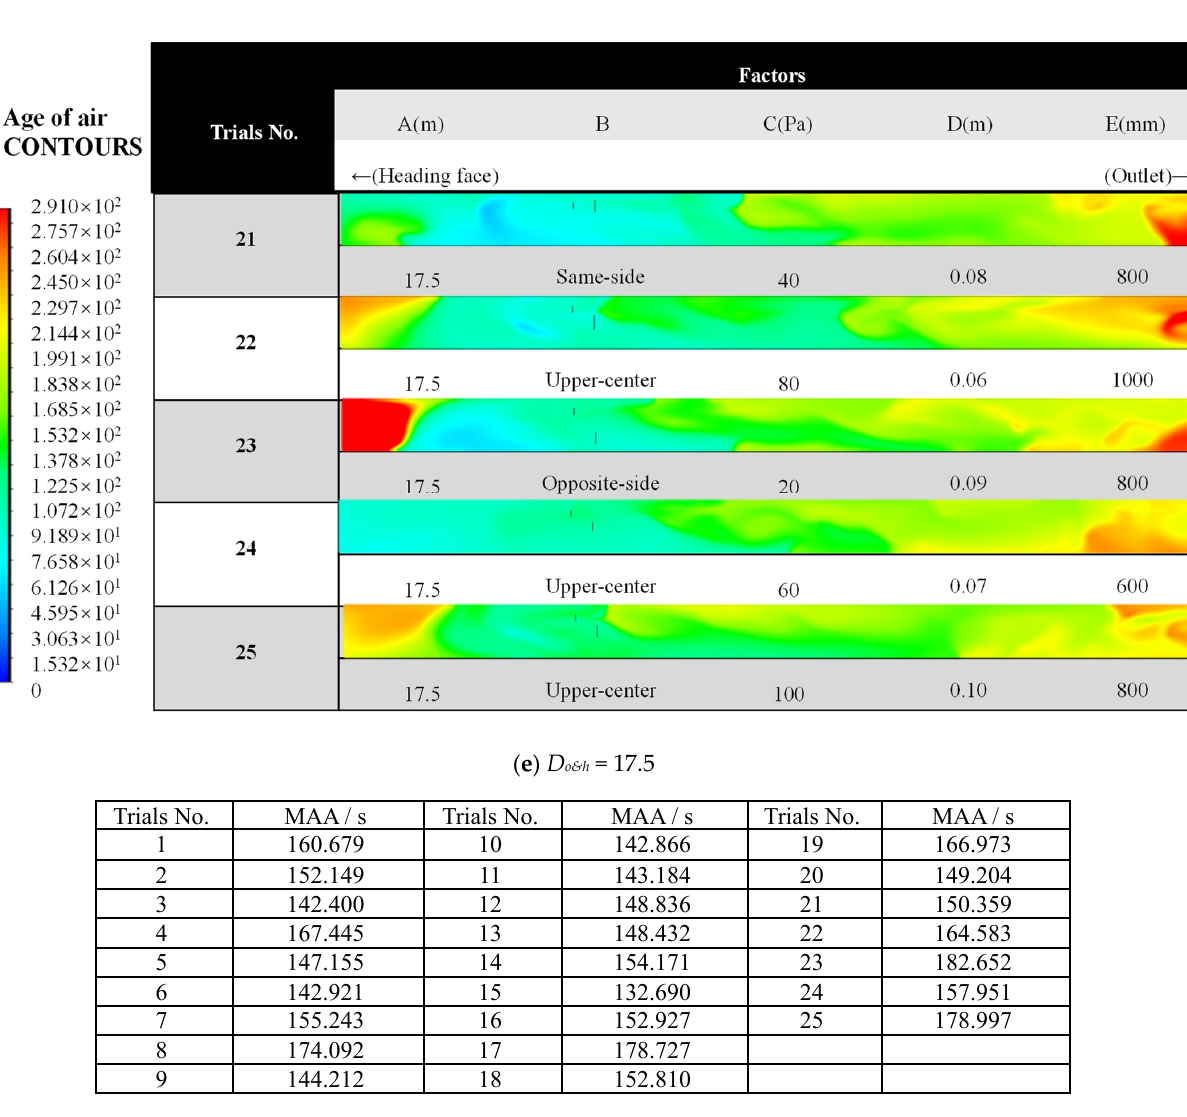
Figure 5. Contours of age-of-air CFD analysis in the single-heading tunnel and the MAA for each trial